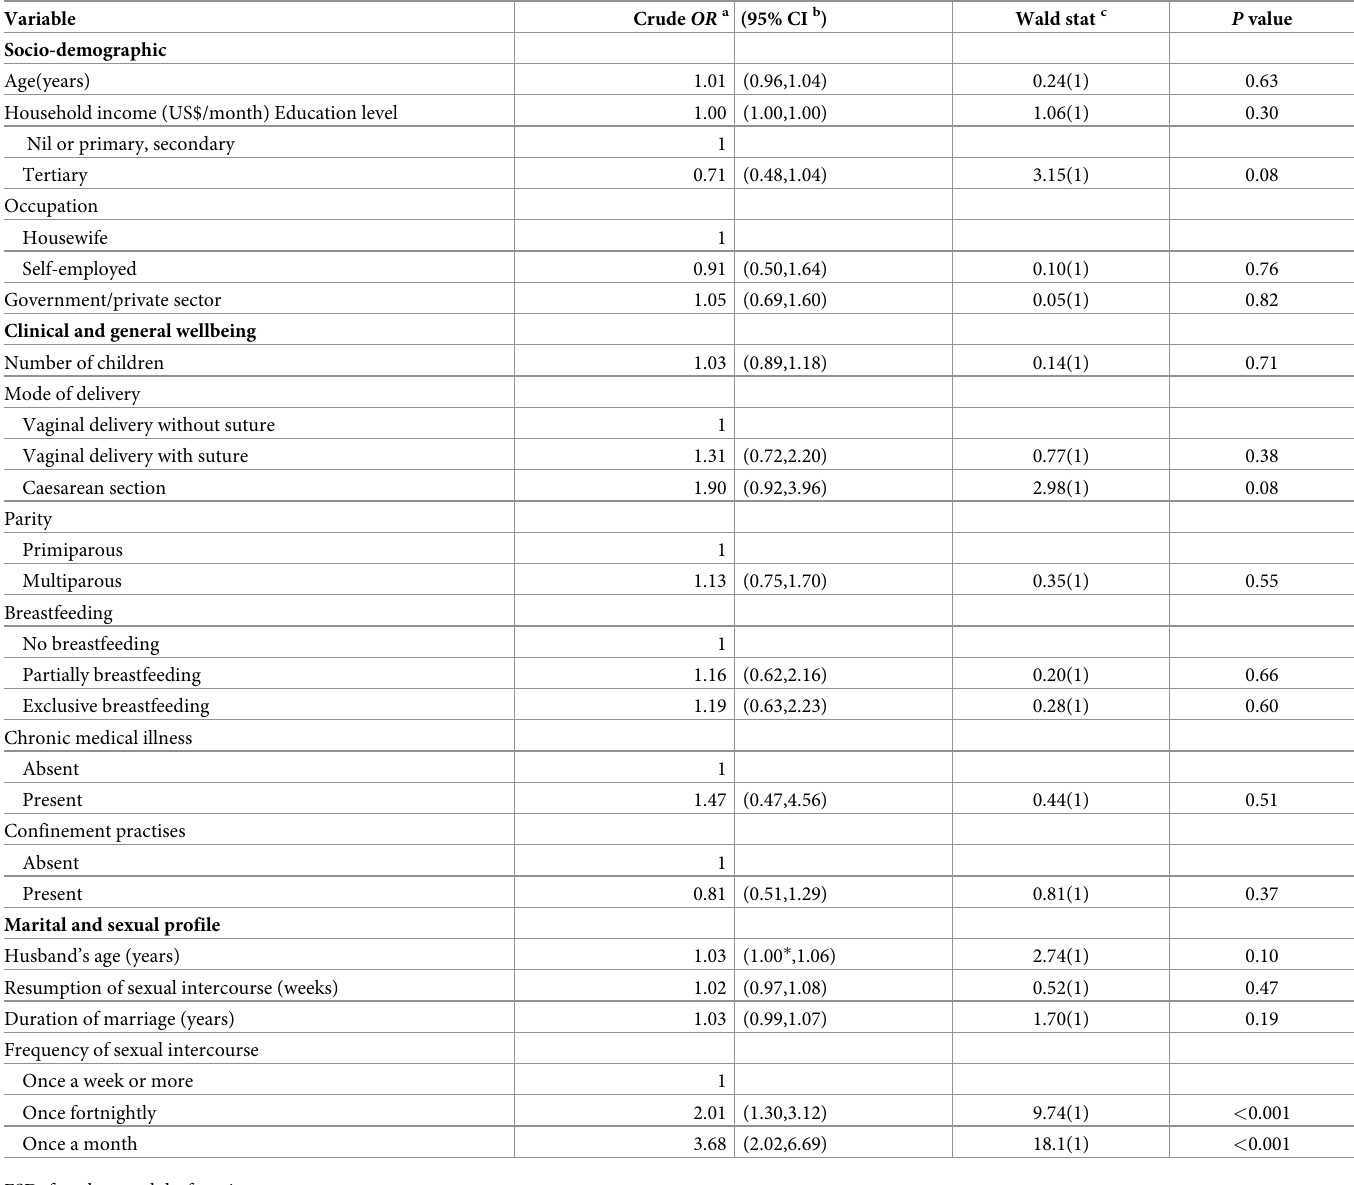
Table 3. Associated factors for female sexual dysfunction using bivariate logistic